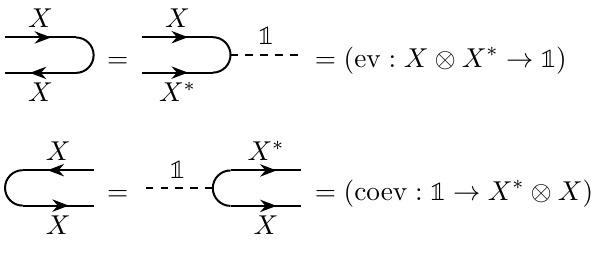
Figure 5. The right dual X ∗ of a string X is given by reversing the orientation. Both the evaluation and coevaluation 1-morphisms are 0d domain